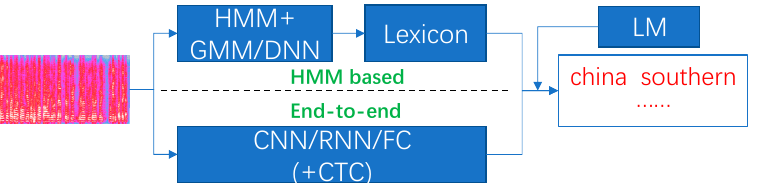
Figure 5. The ASR scheme (hidden Markov model (HMM)-based and end-to-end